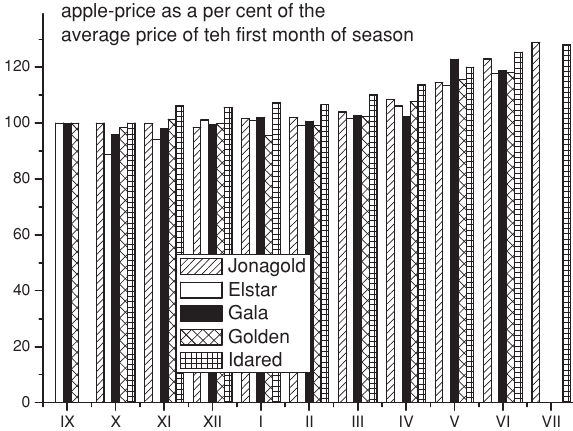
Figure 4. Results of spectral analysis of monthly prices of Gala apple in German market